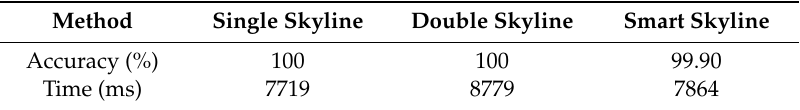
Table 17. SKY–SVM on the synthetic Dataset II.